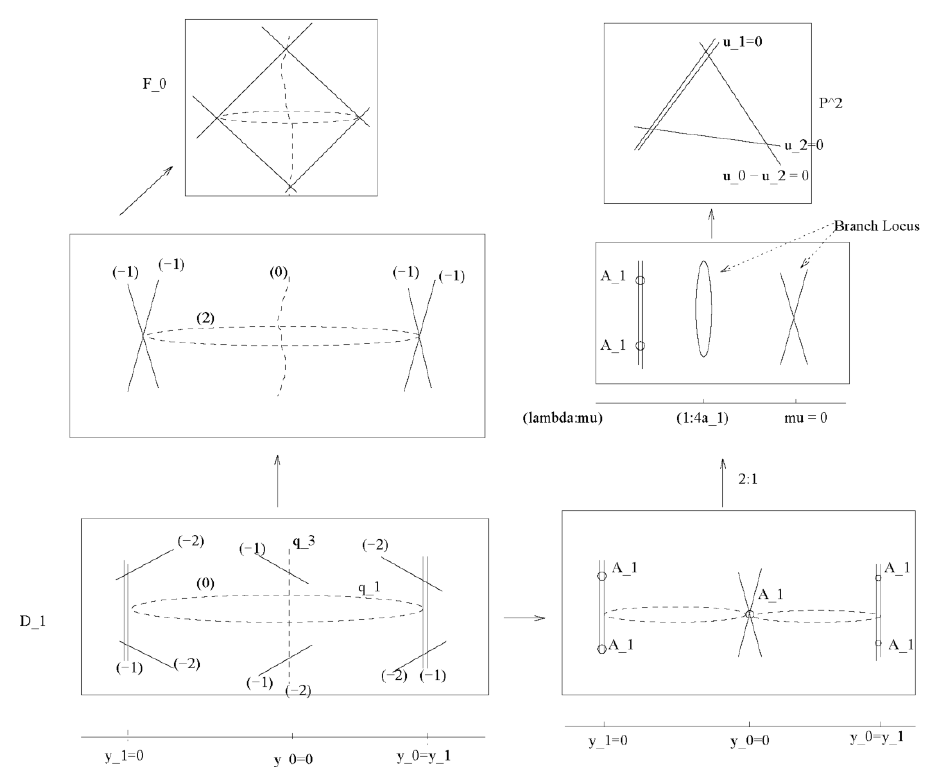
Figure 10. The desingularization of D